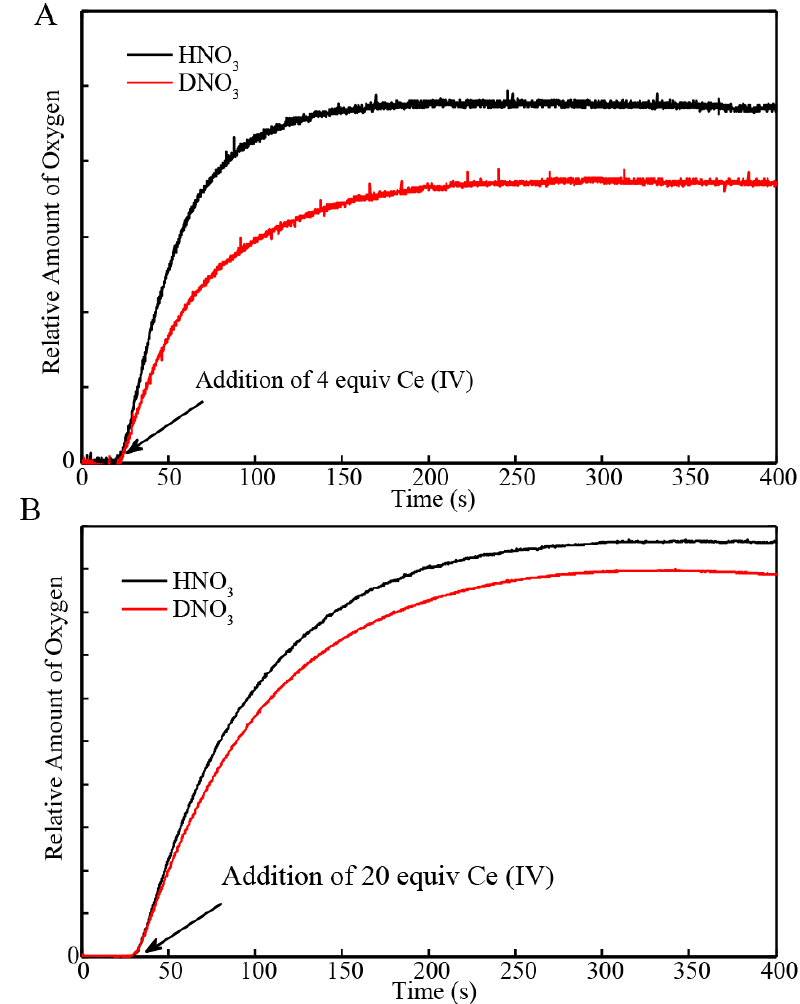
Figure 2. Kinetics of O evolution recorded with oxygen electrode immersed in 2 O and ( B ) D O solution of the blue dimer[3,3] (0.1 mM in 0.1 M HNO ( A ) H 2 2 addition of 4 equiv of Ce(IV) to induce a single turnover as well as 20 equiv of